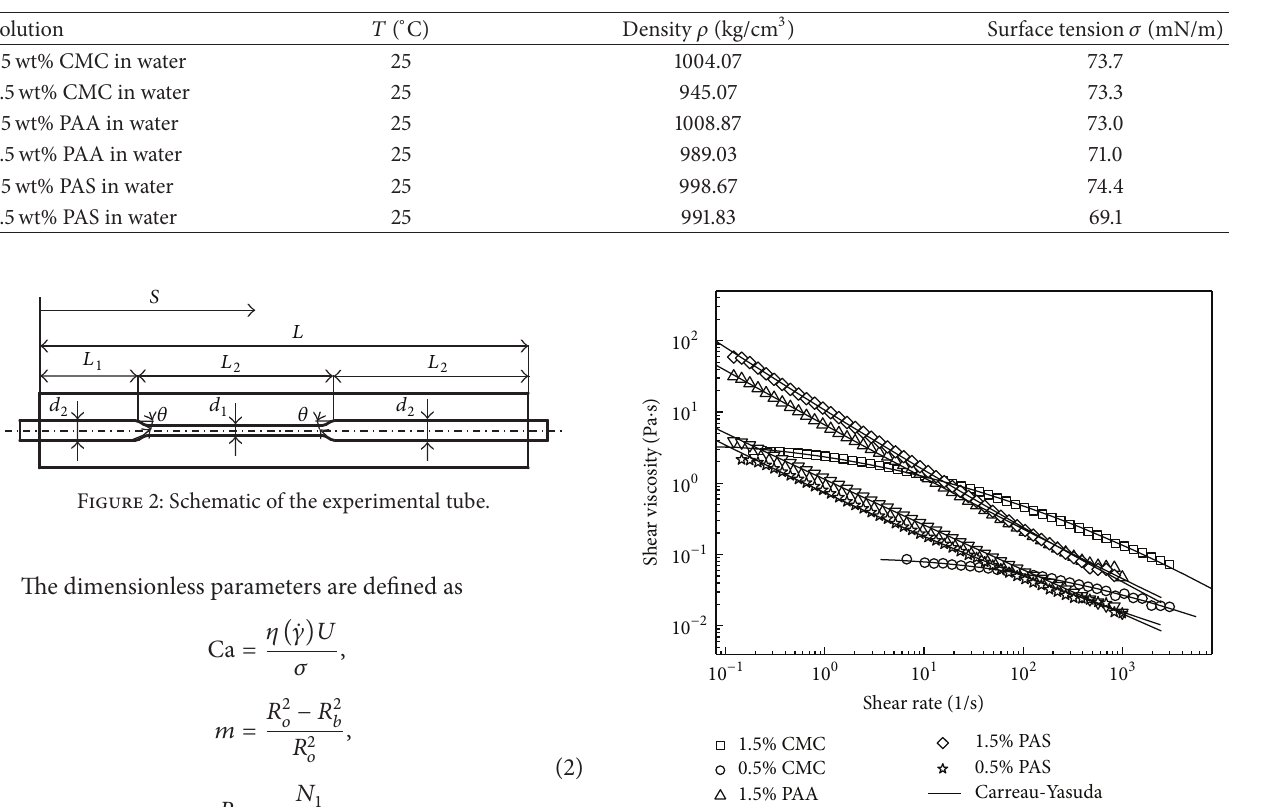
Table 2: Physical properties of viscoelastic fluid.